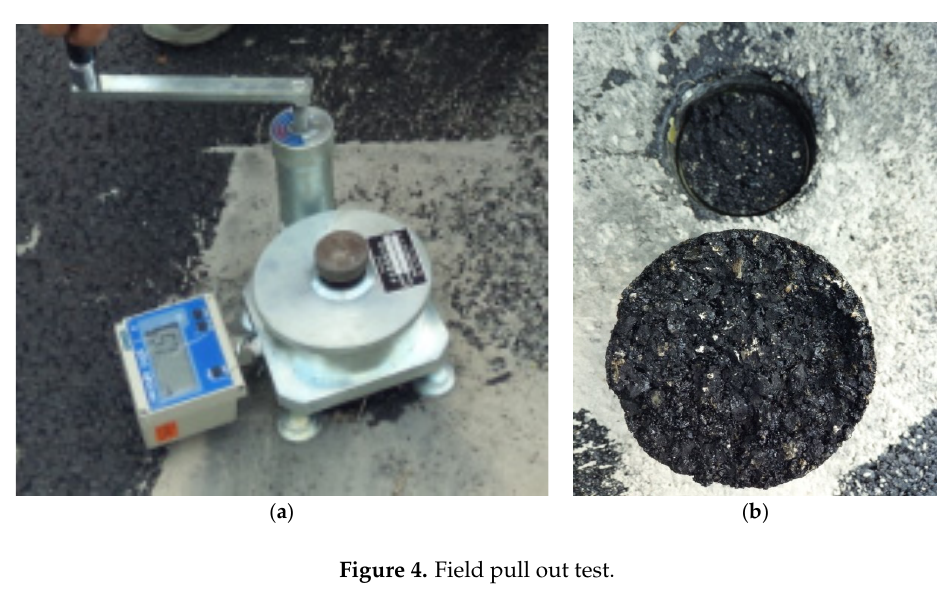
Figure 4. Field pull out test.